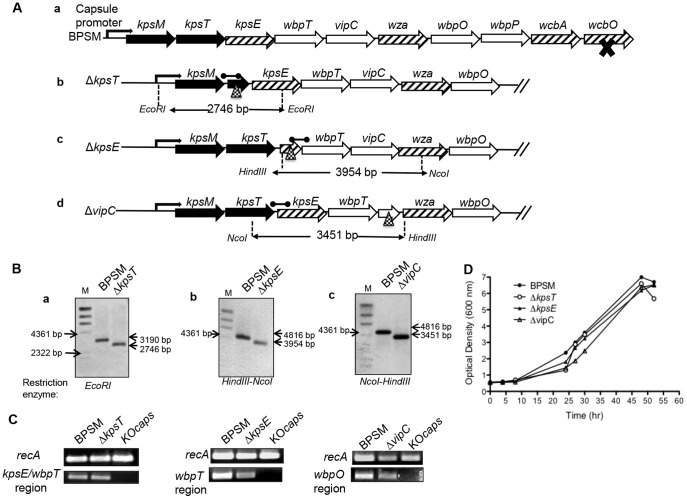
Construction of ΔkpsT, ΔkpsE and ΔvipC B. pertussis mutants.(A) Schematic organization of
B
.
pertussis
 capsule operon. The capsule operon of B. pertussis BPSM strain regulated under the capsule promoter is as shown in panel a, black cross represents mutational insertion found in the locus. Black, hashed and open arrows represent genes involved in polysaccharide transport, polysaccharide modification/translocation and polysaccharide biosynthesis respectively. Adapted from GeneDB. Dotted triangle in panel b (ΔkpsT), c (ΔkpsE) and d (ΔvipC) indicate site of deletion that render each mutant non-capsulated. The DIG-labeled probe binding region (black rounded arrow), restriction sites and size of restriction-digested chromosomal DNA for Southern blot analysis are as shown. (B) Southern blot analysis. Restriction-digested chromosomal DNA from BPSM and ΔkpsT, ΔkpsE and ΔvipC were electrophoresed, transferred onto a nitrocellulose membrane and hybridized with the DIG-labeled probe (Fig. 1A for probe binding site). Panel a, EcoRI-restricted BPSM and ΔkpsT DNA yielded 2.7-kb and 3.2-kb respectively. Panel b, HindIII-NcoI restricted BPSM and ΔkpsE DNA yielded 4.8-kb and 3.9-kb respectively. Panel c, HindIII-NcoI restricted BPSM and ΔvipC DNA yielded 4.8-kb and 3.4-kb respectively. (C) Transcription efficacy of downstream gene. Total RNA was extracted from exponential SS liquid cultures of BPSM, KOcaps, ΔkpsT, ΔkpsE and ΔvipC was reverse-transcribed followed by PCR amplification using primers specific to the endogenous control gene recA, and primers mapping to the respective downstream region of the deleted ORFs. The KOcaps strain which was deleted for the entire capsule locus was used as a negative control. (D) Growth kinetic profiles. SS liquid medium was inoculated with BPSM (closed circles), ΔkpsT (open circles), ΔkpsE (closed triangles) and ΔvipC (open triangles) at initial OD600 nm of 0.5 at time-point 0 hour. OD600 nm was monitored for 52 hrs incubation at 37°C. The growth kinetics assay was performed twice independently for each strain and each culture condition. The data shown is representative of two independent experiments.